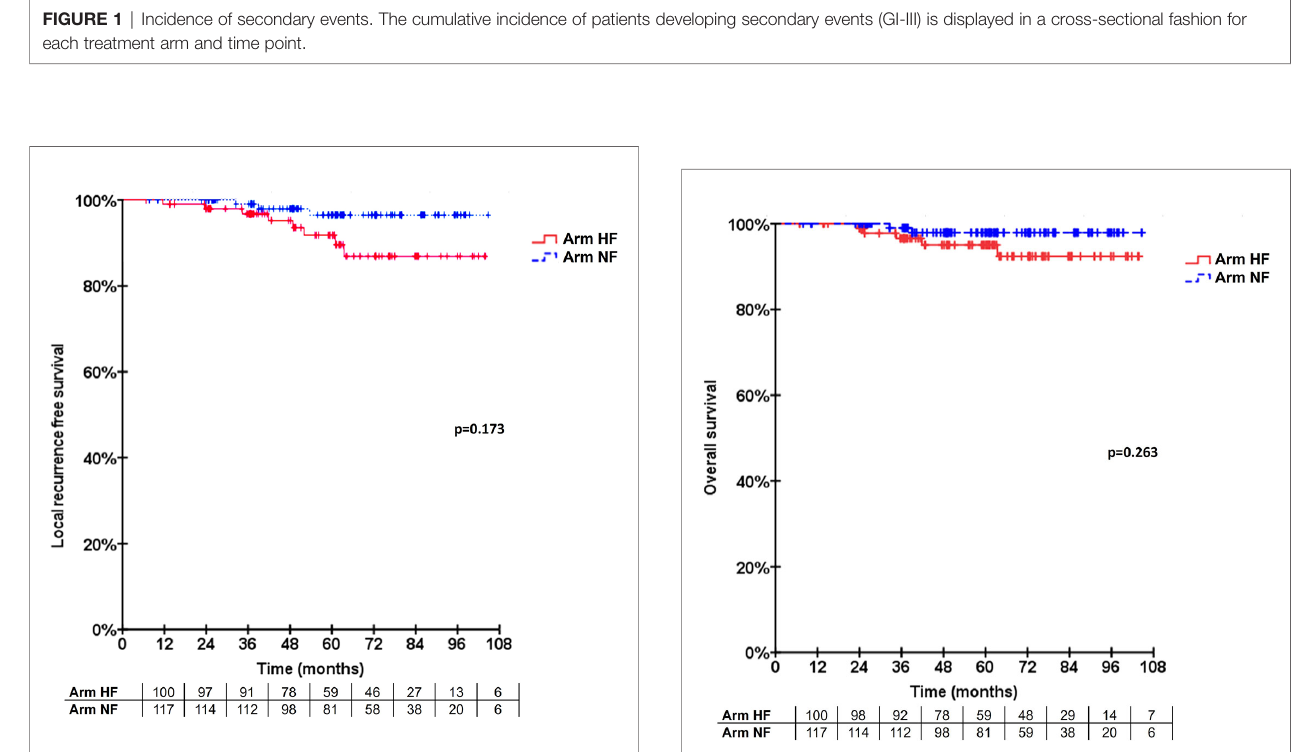
FIGURE 2 | Cumulative local recurrence rate. Longitudinal local control displayed according to the Kaplan-Meier method. FIGURE 3 | Overall survival. Kaplan-Meier curves for the estimated overall